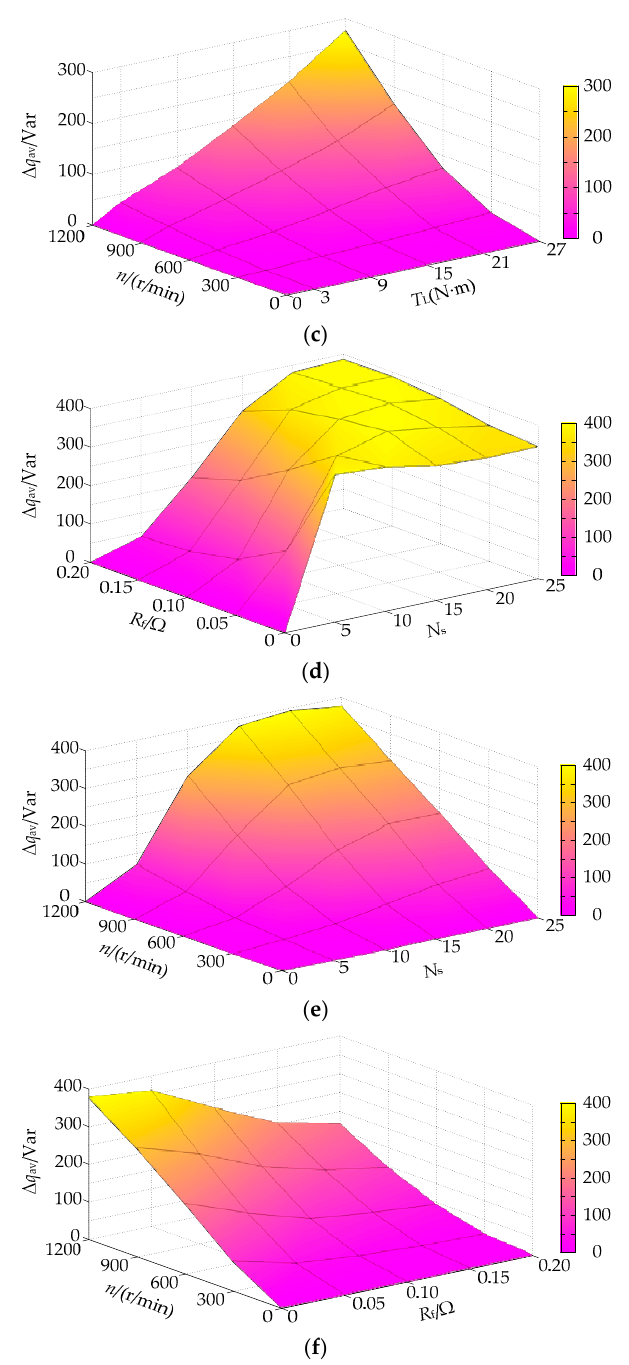
Figure 13. Curves among q av , N S , T L , R f and n : ( a ) q av with N S and T L ( R f = 0.1 Ω , n = 1200 rpm); ( b ) q av with R f and T L ( N S = 10, n = 1200 rpm); ( c ) q av with n and T L ( R f = 0.1 Ω , N S = 10); ( d ) q av with R F and N S ( T L = 27 N·m, n = 1200 rpm); ( e ) q av with n and N S ( R f = 0.1 Ω , T L = 27 N·m); (f) q av with n and R f ( T L = 27 N·m, N S = 10).